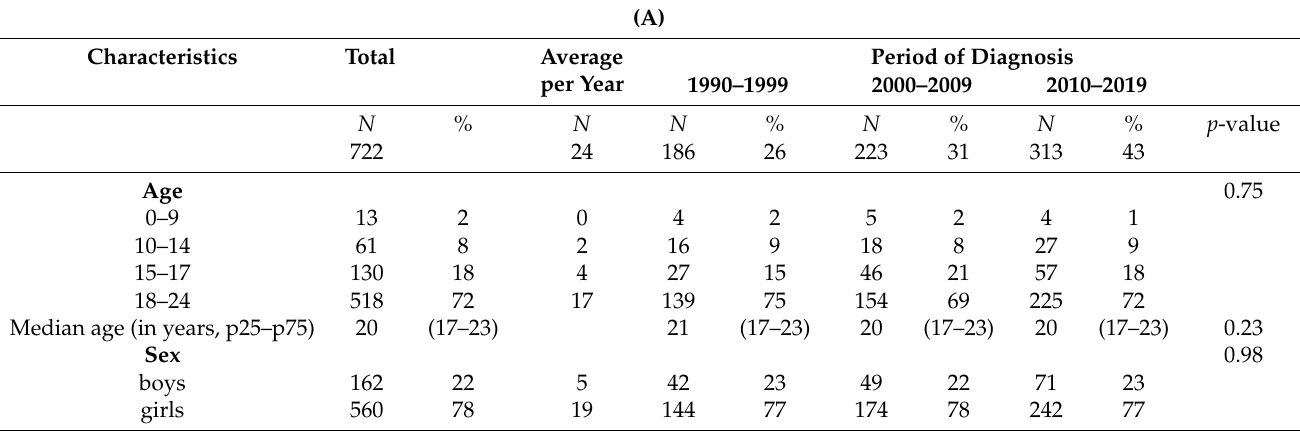
than 40% ( n = 300) of the patients with DTC, lymph node metastases were found in the pathological report. Children and adolescents were diagnosed with lymph node metastases more often compared to young adults (54% vs. 40%, p = 0.001). Significantly more lymph node metastases were reported in the period 2000–2009 (52%, p < 0.02). Distant metastases were reported in 3% of the patients with DTC in total, and were more frequently found in children (15% vs. 2% in older patients, p < 0.001). The characteristics of DTC by age group are presented in Table S3. Table 1. ( A ) Characteristics of differentiated thyroid carcinoma patients aged 0–24 years in the Netherlands, 1990–2019. ( B ) Characteristics of medullary thyroid carcinoma patients aged 0–24 years in the Netherlands,